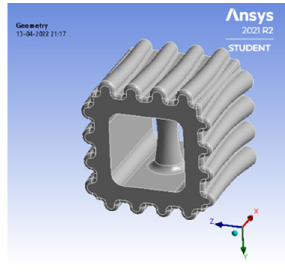
Figure 11. Sheep horn scale.